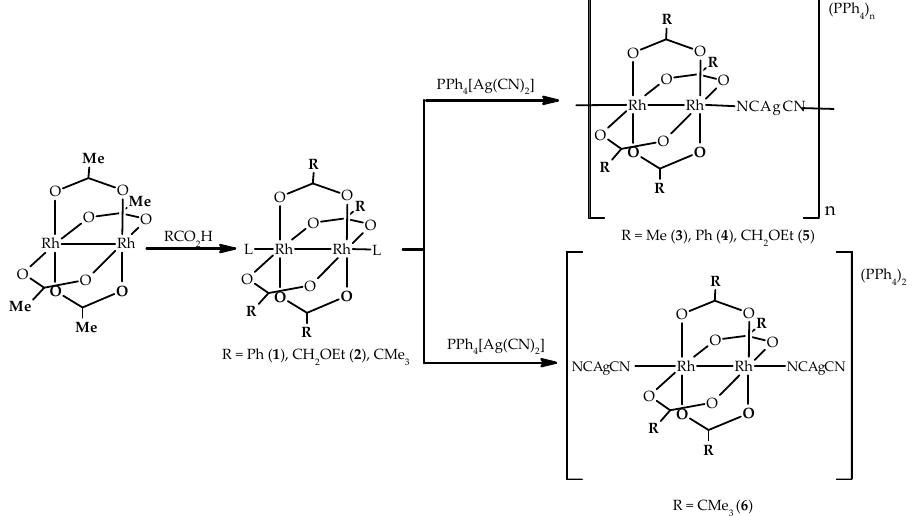
Figure 1. Synthetic approach employed to prepare 1 – 6 .